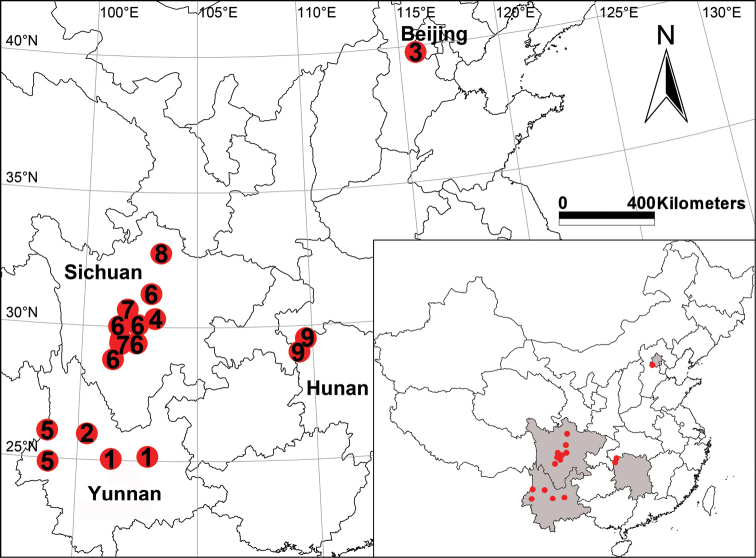
Distribution records of Pimoa species from China 1P.anatolica2P.binchuanensis sp. nov. 3P.clavata4P.lata5P.lihengae6P.reniformis7P.trifurcata8P.wanglangensis9P.xinjianensis sp. nov.